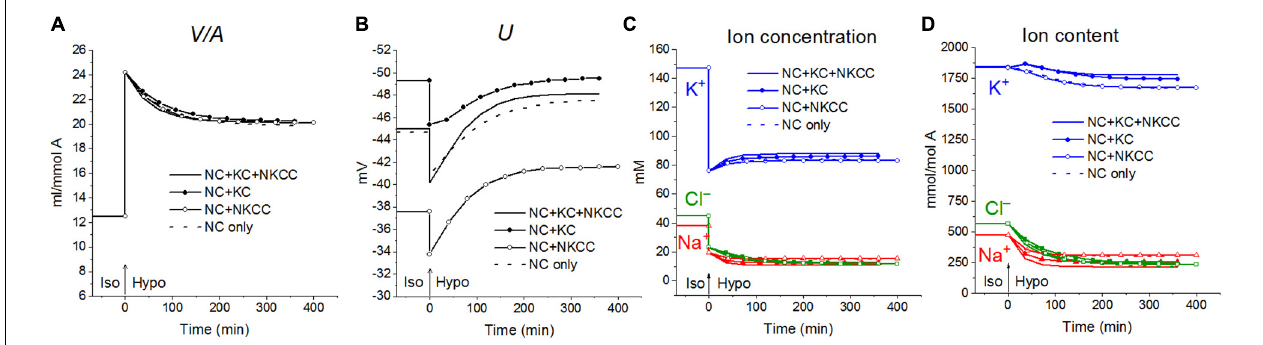
FIGURE 3 | Rearrangement of ionic homeostasis during the Iso-Hypo transition, calculated for a system with different sets of cotransporters at the unchanged over time parameters like in U937 cells, equilibrated with the standard RPMI medium. The parameters for the calculation are given in Table 2 , cells B . The arrows at t = 0 show the replacement of a standard medium of 310 mOsm with a hypoosmolar medium of 160 mOsm, obtained by decreasing the NaCl concentration by 75